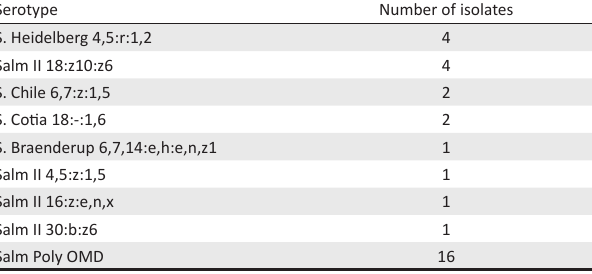
TABLE 1: Serotypes of Salmonella spp. recovered from 32 faecal isolates of juvenile dogs co-infected with canine parvovirus and an apparently healthy cohort of age-matched